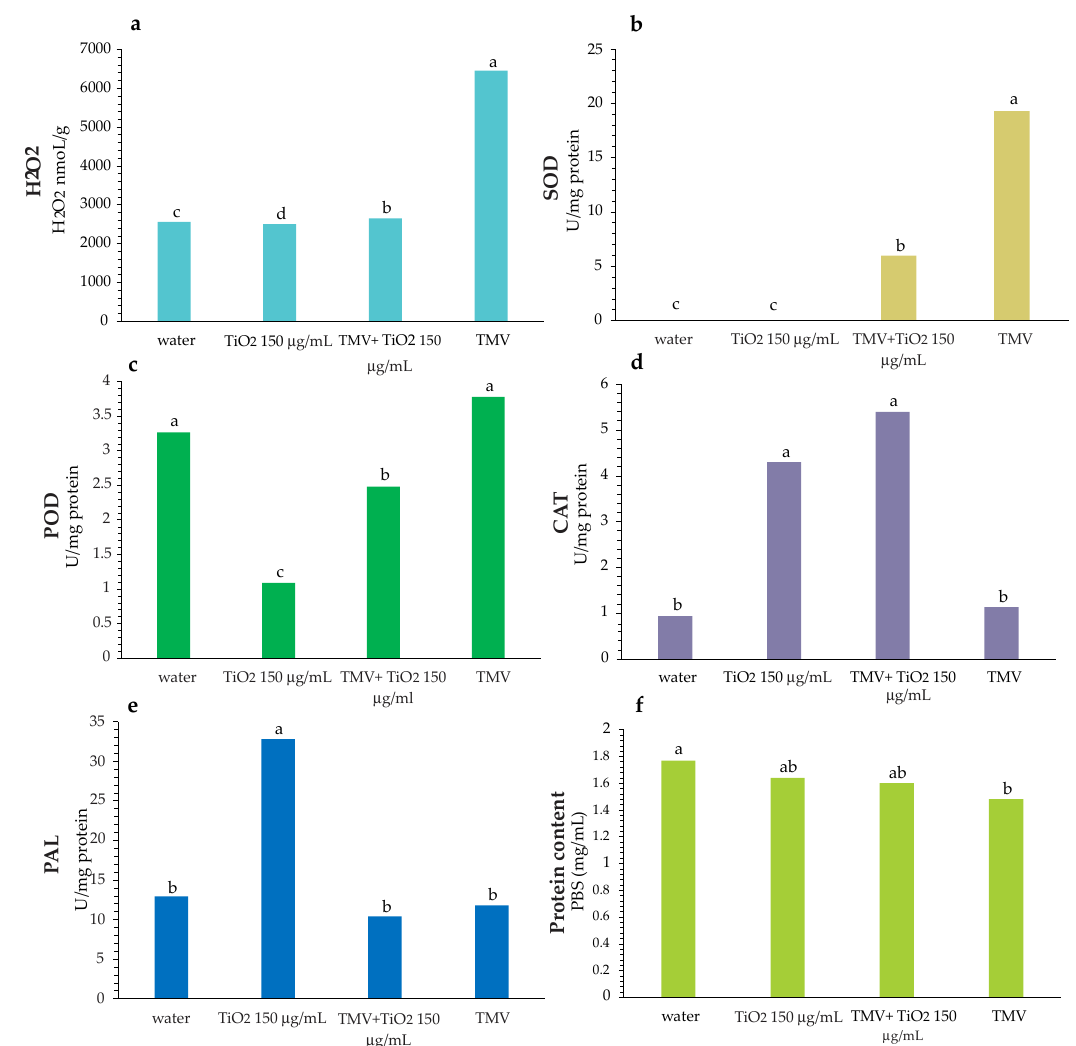
Figure 6. ( a ) Peroxide concentration; ( b ) SOD; ( c ) POD; ( d ) CAT; ( e ) PAL; ( f ) protein in leaves of chili pepper infected with TMV and treated with TiO 2 NPs. The letters indicate the significant difference between treatments ( α = 0.05).